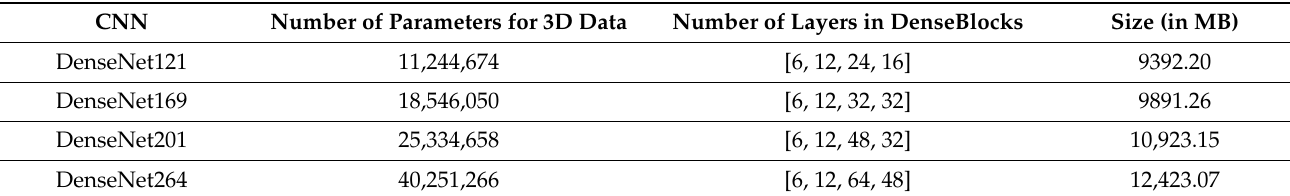
Table 3. Implemented DenseNet architectures.